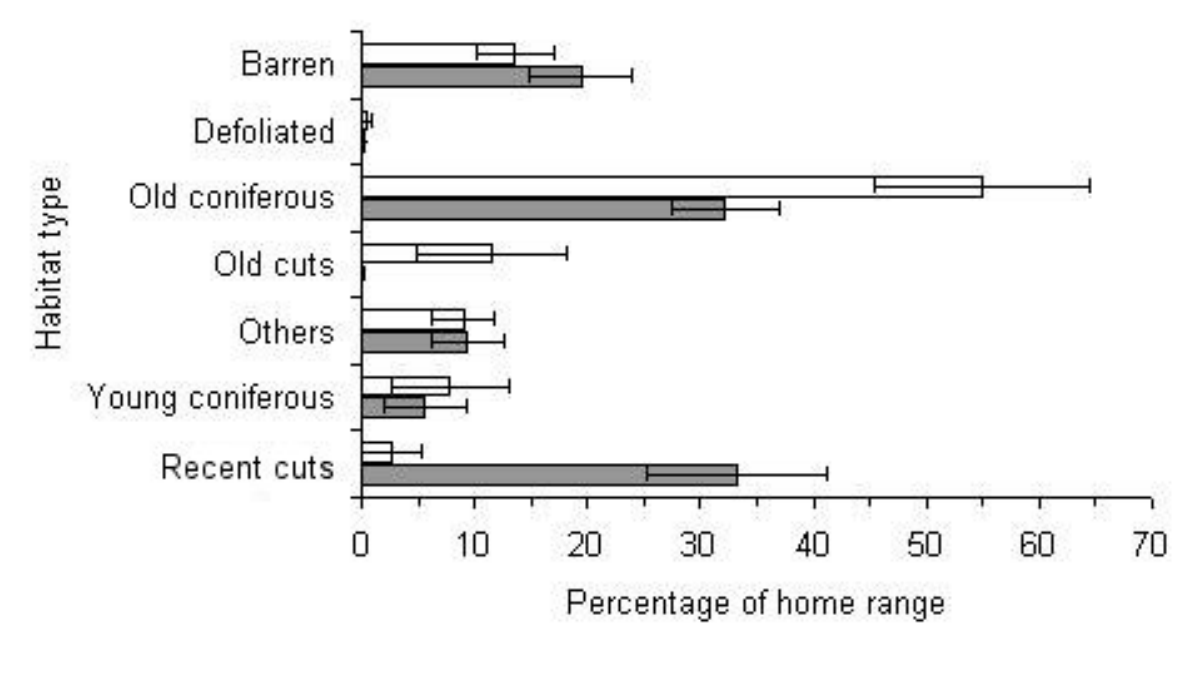
Fig. 3. Habitat composition (mean ± SE) of Black-backed Woodpecker home ranges (gray bars; n = 8) and randomly distributed home ranges (empty bars; n = 8). Habitat types were defined as barren, stands defoliated by windthrows and spruce budworm outbreak, young (<90 years) and old (>90 years) coniferous stands, and young (<5 years) and old (>5 years)